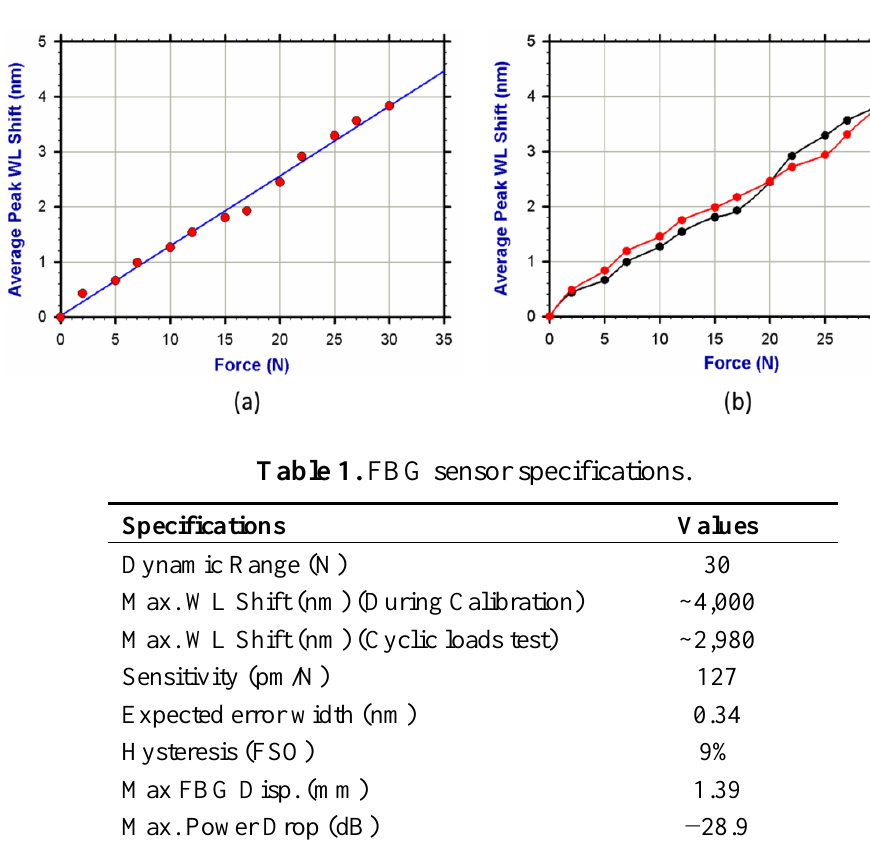
Figure 5. FBG sensor calibration. ( a ) The FBG peak wavelength shift versus the applied force and ( b ) the hysteresis error (≈0.09 FSO) shown by the sensor.